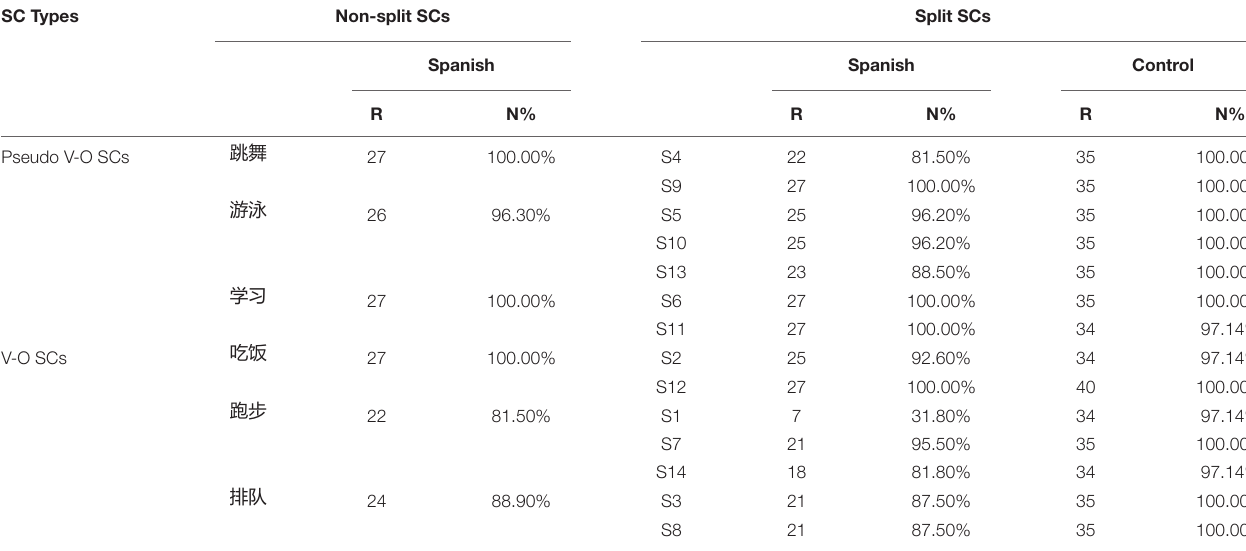
TABLE 5 | Recognition of split SCs. SC Types